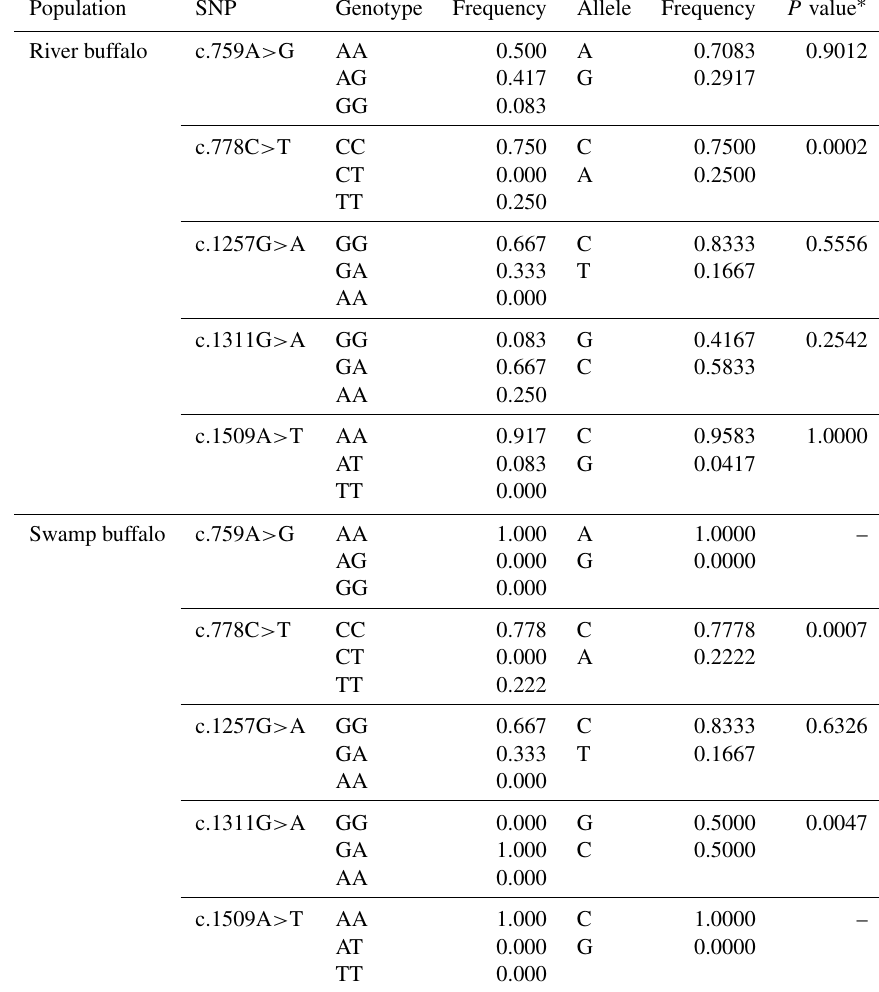
Table 3. Genetic information on the SNPs found in two types of